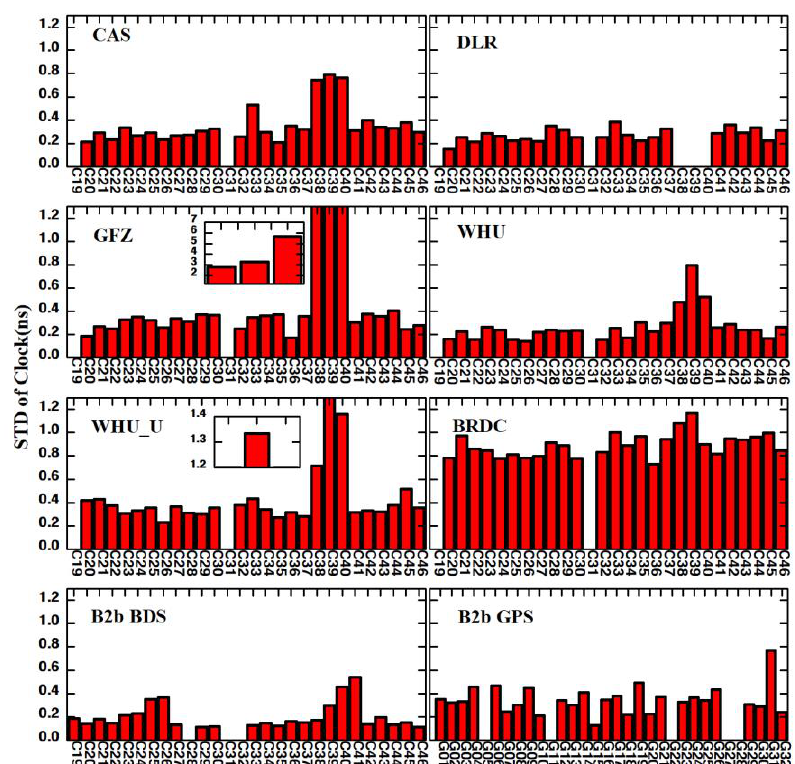
Figure 5. STD of real-time orbit clock errors.